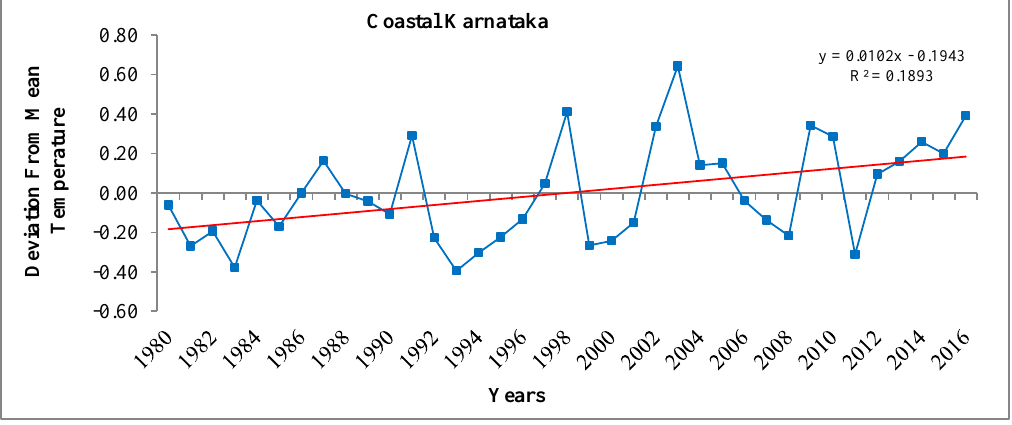
Figure 8. Average Annual Temperature